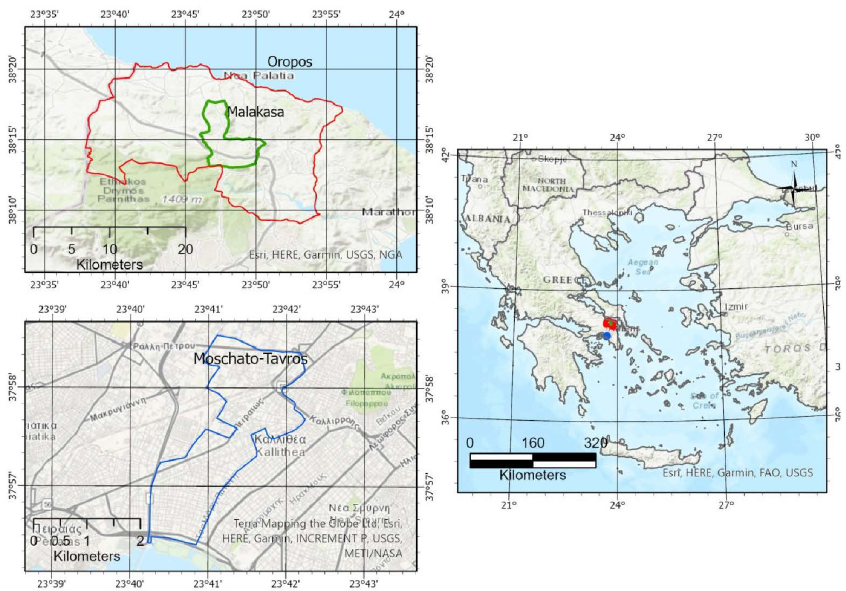
Figure 1. Map of the survey areas: Red frame: Territorial borders of the Oropos Municipality; Green frame: Territorial borders of the Malakasa community; Blue frame: Territorial borders of the Moschato-Tavros